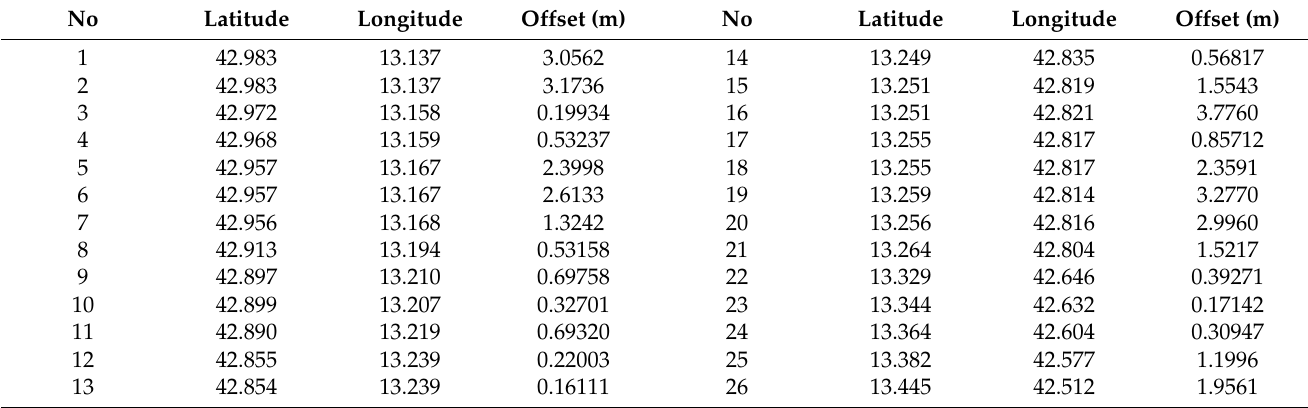
Table A2. Scarp offset measurements through topography